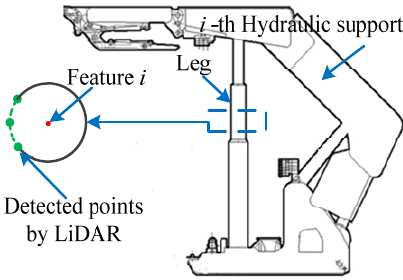
Figure 5. Feature detected from the i -th hydraulic support by LiDAR.